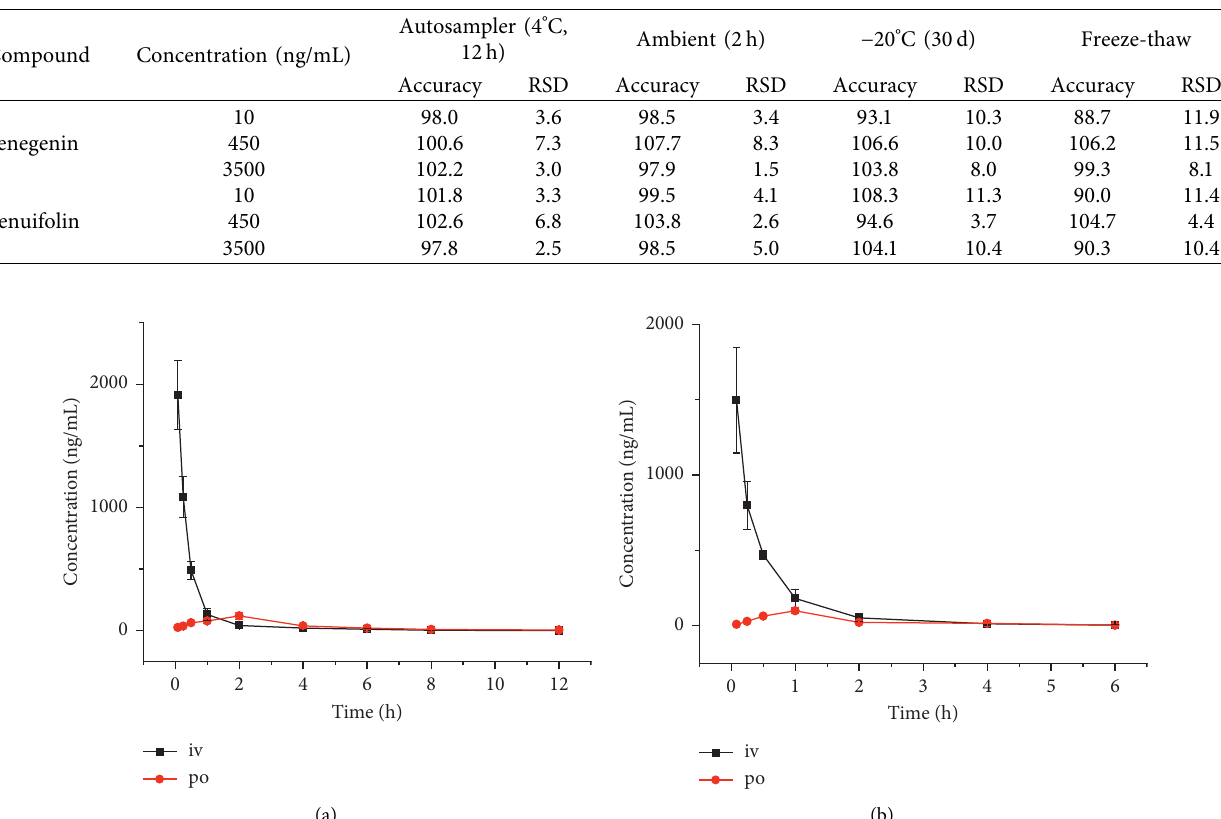
Table 2: Stability of senegenin and tenuifolin in mouse blood.